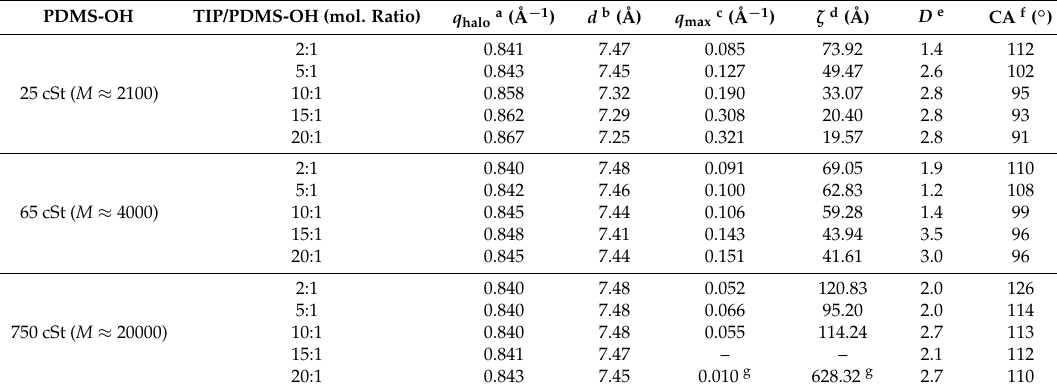
Table 2. Structural properties of the Ti-PDMS hybrid materials obtained from SAXS and water contact angle analysis. PDMS-OH TIP/PDMS-OH (mol. Ratio)